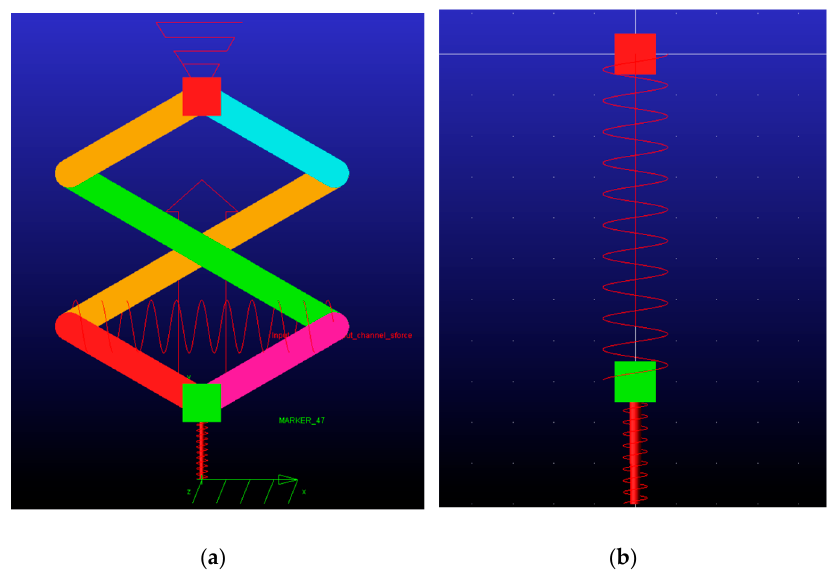
Figure 14. Adams simulation for the double-diamond isolator element structure ( a ) and linear spring isolator element structure ( b ).